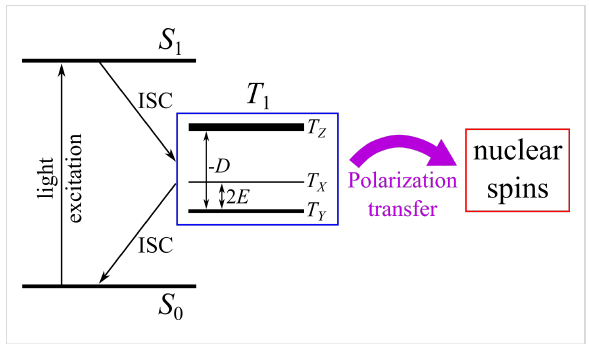
Figure 12: Scheme of triplet-state OEP and ONP formation. In anisotropic molecules, the ISC process S 1 → T 1 has a different rate for the three triplet states resulting in OEP of the T 1 -state; the triplet states, T x , T y , and T z , are indicated as well as the ZFS parameters, D and E . Alternatively, OEP can be formed due to the different T 1 depop- ulation rates in the ISC process T 1 → S 0 . ONP is formed by spin-polari- zation transfer from the polarized T 1 state to nuclear spins of the